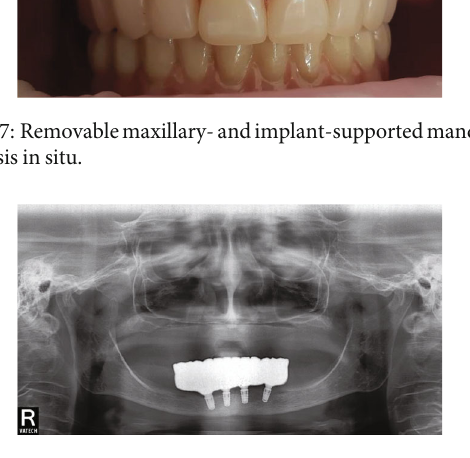
Figure 8: Panoramic view. Radiographic follow-up a year after